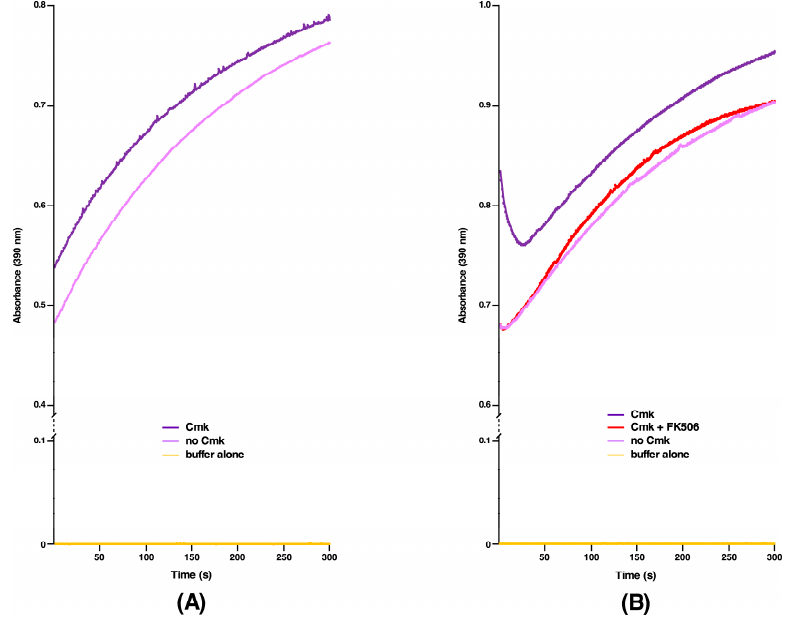
Figure 6. The RNA polymerase-binding protein DksA exhibits a PPIase activity that is comparable to that of FkpB and is inhibited by FK506. The PPIase activity was measured in the chymotrypsin- coupled assay using N -Suc-Ala-Ala- cis -Pro-Phe- p -nitroanilide as the substrate. ( A ) The comparative PPIase activity of FkpB, FklB and DksA proteins. ( B ) DksA was incubated with a two-fold molar excess of FK506 for 5 min at 10 °C prior to the PPIase activity measurement. The PPIase activity of DksA in the presence or absence of FK506, along with uncatalyzed reaction are plotted. ( C ) Measurement of PPIase activity of wild-type DksA and its variants. Proteins were used at a concentration of 5 μ M each.